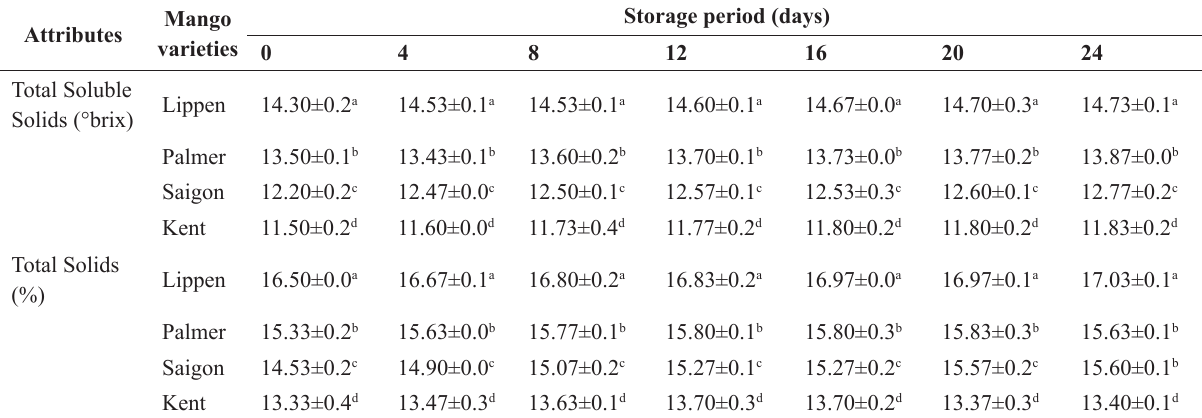
Table 2: Total soluble solids (°brix) and total solids (%) of juice produced from four mango varieties during storage. Attributes